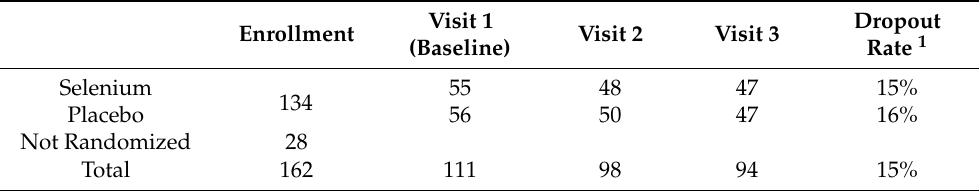
Table 1. Participants who completed the study by visit and study